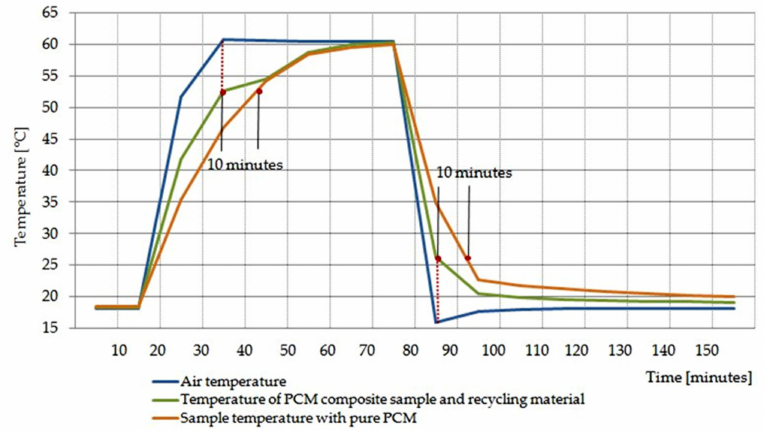
Figure 12. Chart of recorded temperature changes of pure PCM packets and packets with PCM composite with carbon recyclate during their heating and cooling according to the assumptions of experiment No. 6.